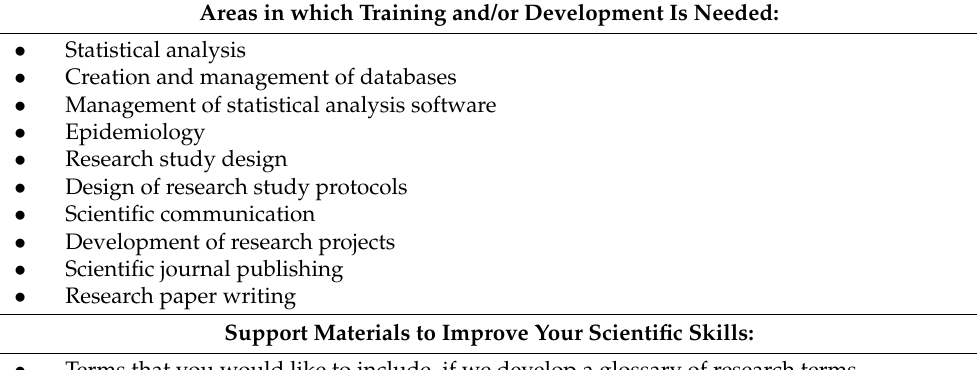
Table 3. Summary of the data on training and development needs collected in the HACTO-Screen survey. Areas in which Training and/or Development Is Needed: